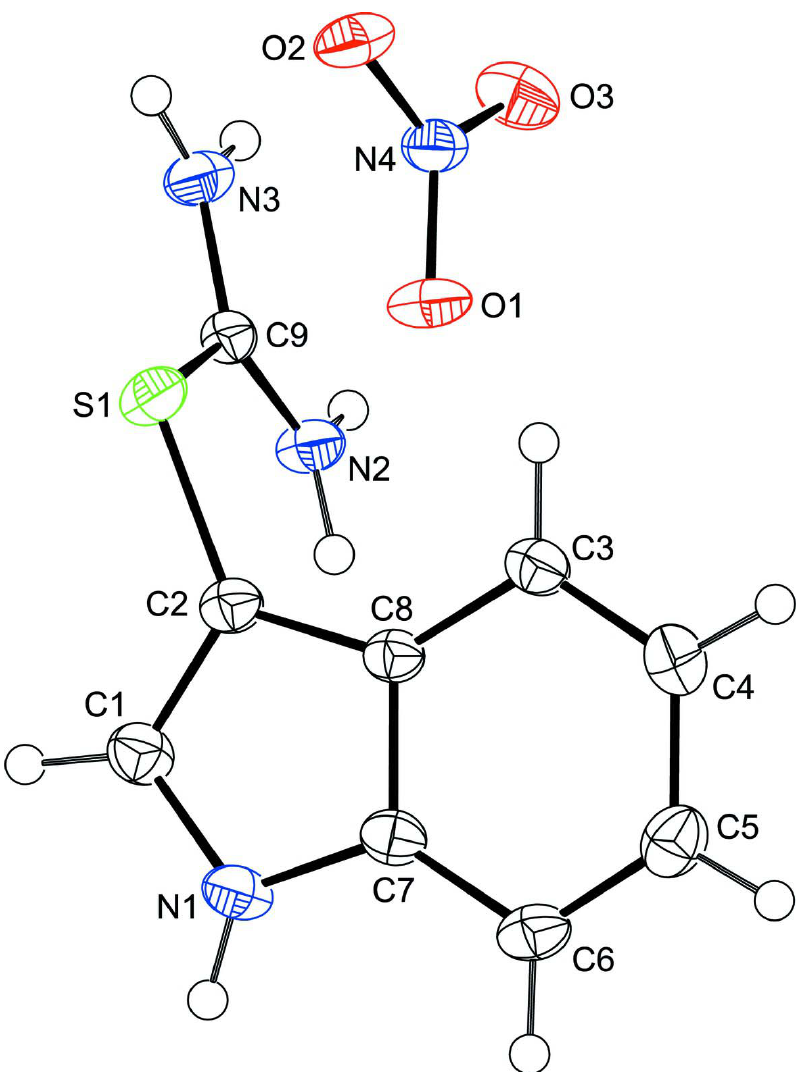
The molecular structure of (I). Displacement ellipsoids are drawn at the 50% probability level and H atoms are shown as small spheres of arbitrary